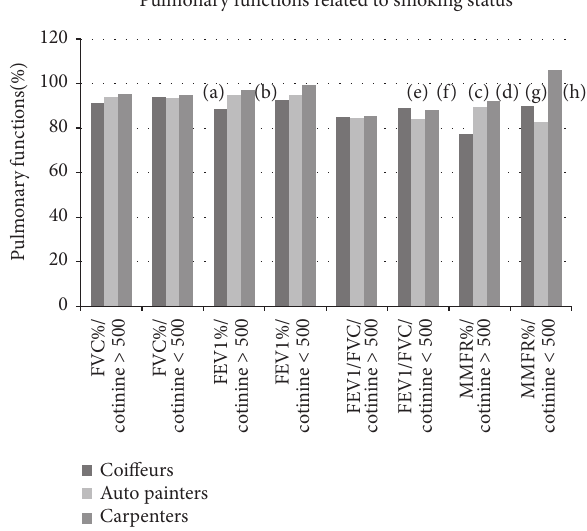
Figure 2: Relationship between mean predicted values and pul- monary functions related to smoking (one-way ANOVA was used to compare groups). (a) % FEV1 of coiffeurs < % FEV1 of auto painters ( 𝑃 = 0.032 ). (b) % FEV1 of coiffeurs < % FEV1 of carpenters ( 𝑃 = 0.004 ). (c) % MMFR of coiffeurs < %MMFR of auto painters ( 𝑃 = 0.018 ).(d)%MMFRofcoiffeurs < %MMFRofcarpenters( 𝑃 = 0.006 ). (e) FEV1/FVC of auto painters < FEV1/FVC of coiffeurs ( 𝑃 = 0.013 ). (f) FEV1/FVC of auto painters < FEV1/FVC of carpenters ( 𝑃 = 0.034 ). (g) % MMFR of coiffeurs < % MMFR of carpenters ( 𝑃 = 0.017 ). (h) % MMFR of auto painters < % MMFR of carpenters ( 𝑃 = 0.003